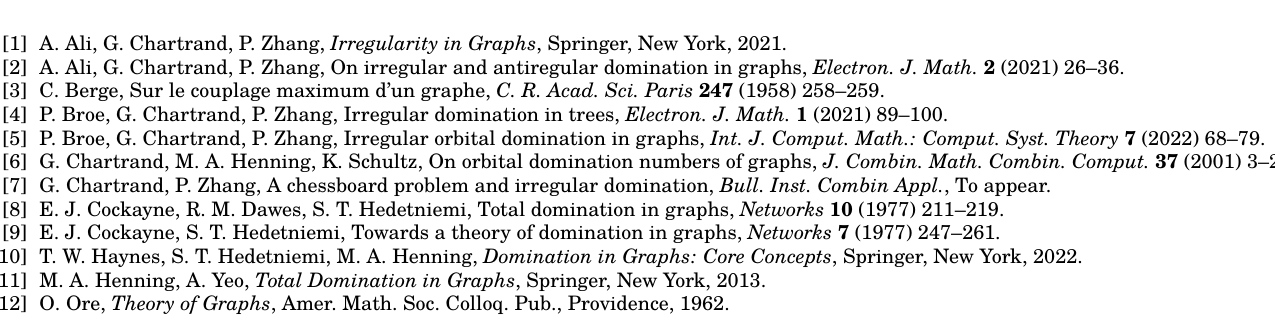
the proof of Theorem 10